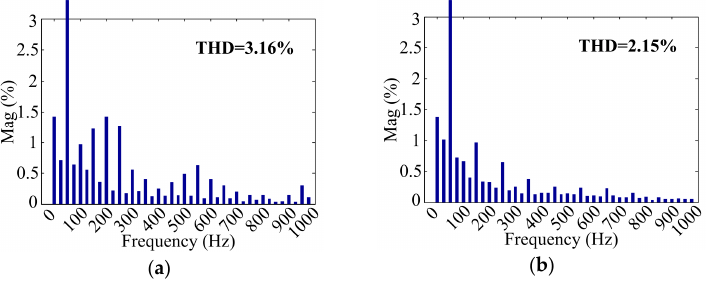
Figure 15. The FFT analysis of grid-connected converter starting in rectifier mode with NFF. ( a ) SCR = 10; ( b ) SCR = 2.